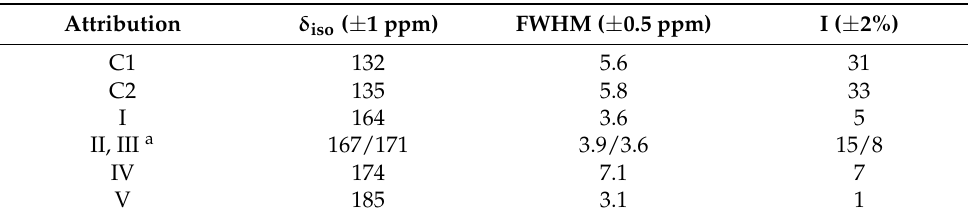
Table 1. Spectral parameters were obtained from the deconvolution of the 13 C NMR spectrum measured with direct polarization. δ iso is the isotropic chemical shift, FWHM is the full-width at half-maximum, and I is the relative area for each spectral component.